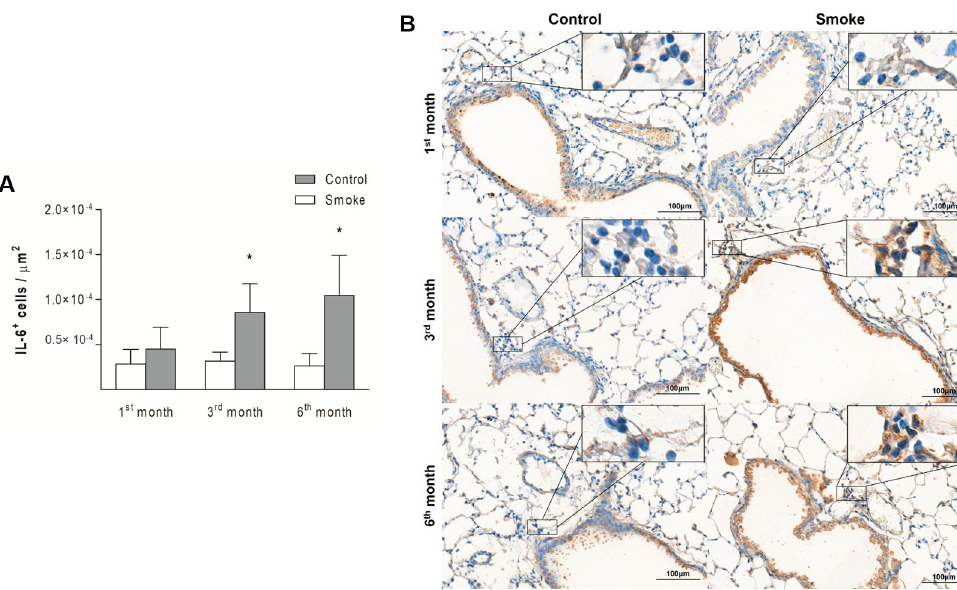
Fig 8. IL-6 + cells in peribronchovascular areas. The numbers of IL-6 + cells in peribronchovascular areas obtained for the Control groups after 1 (n = 6), 3 (n = 5), and 6 (n = 4) months and Smoke groups after 1 (n = 6), 3 (n = 5), and 6 (n = 6) months are presented as the means ± SDs. (A) Significant differences were found after 3 ( � P = 0.0065, t-test) and 6 ( � P = 0.0108, t-test) months. (B) Representative photomicrographs of IL-6 + cells in peribronchovascular areas are shown at 200 × magnification, and images at 1000 × magnification are shown in each insert.